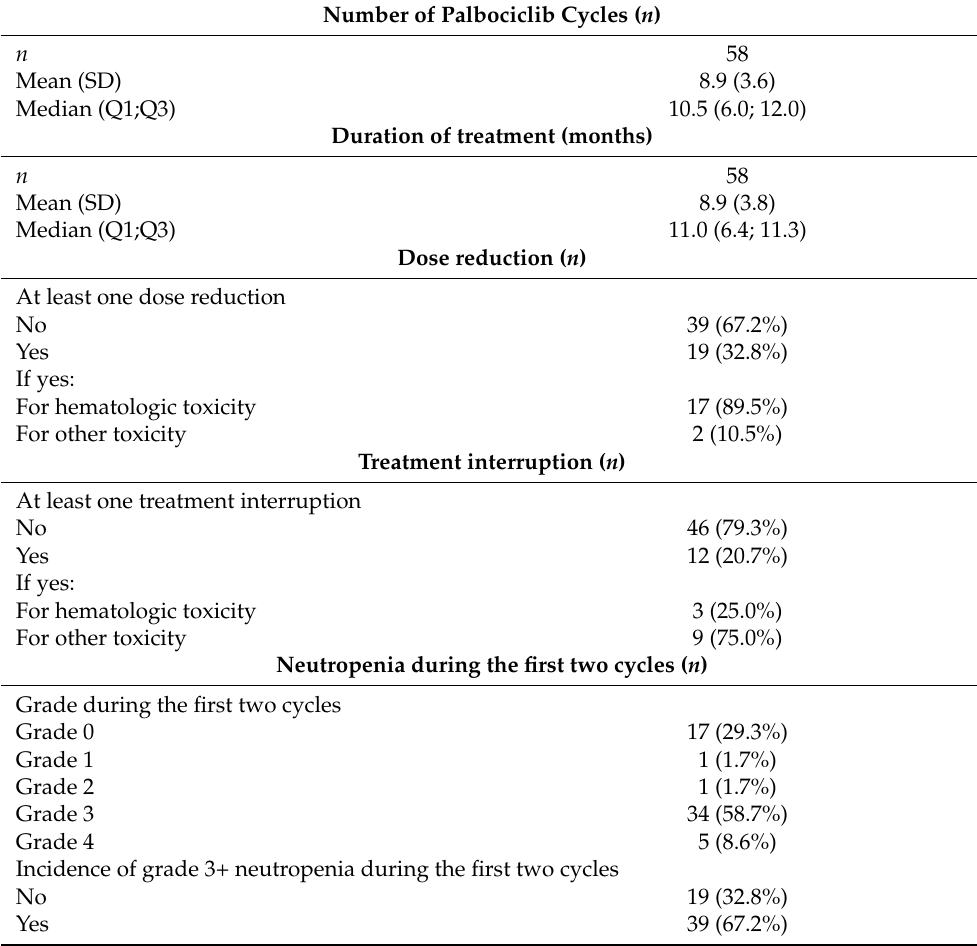
Table 1. Treatment interruption/dose modification and toxicity occurrence (safety population, n =